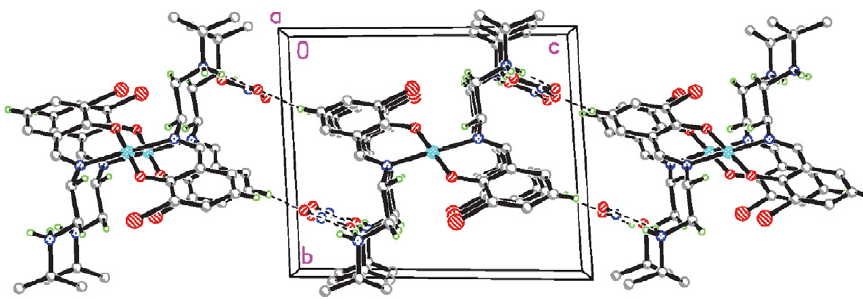
Figure 6. Molecular packing structure of complex 3 , viewed along the a axis. Hydrogen bonds are shown as dashed lines.